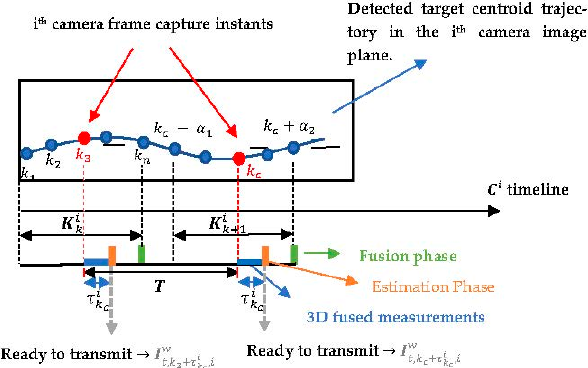
(cid:3036) denotes the denotes the k c (cid:3278) (cid:2869) + 𝛼 (cid:2870) is